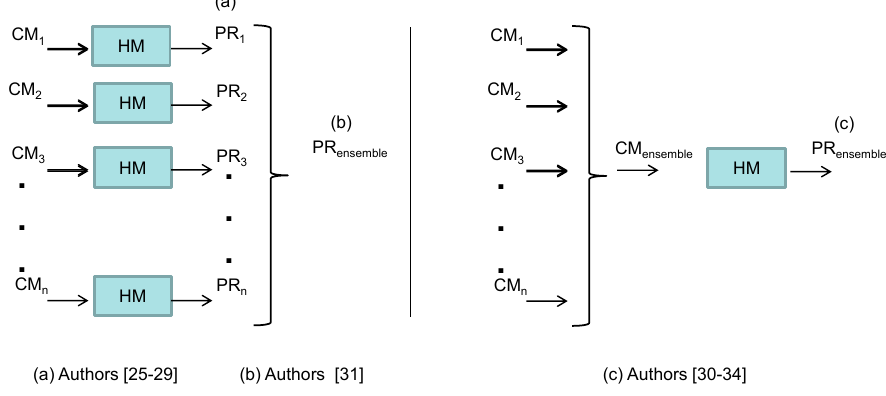
Figure 1. Strategies for reducing uncertainties.